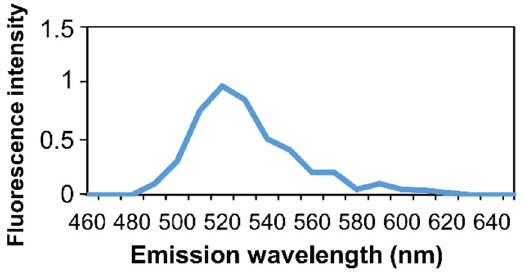
Figure 6. Microspectroscopy analysis of non-decalcified rat bone section. In situ microspectroscopy analysis of the Alexa Fluor 488 fluorescence.